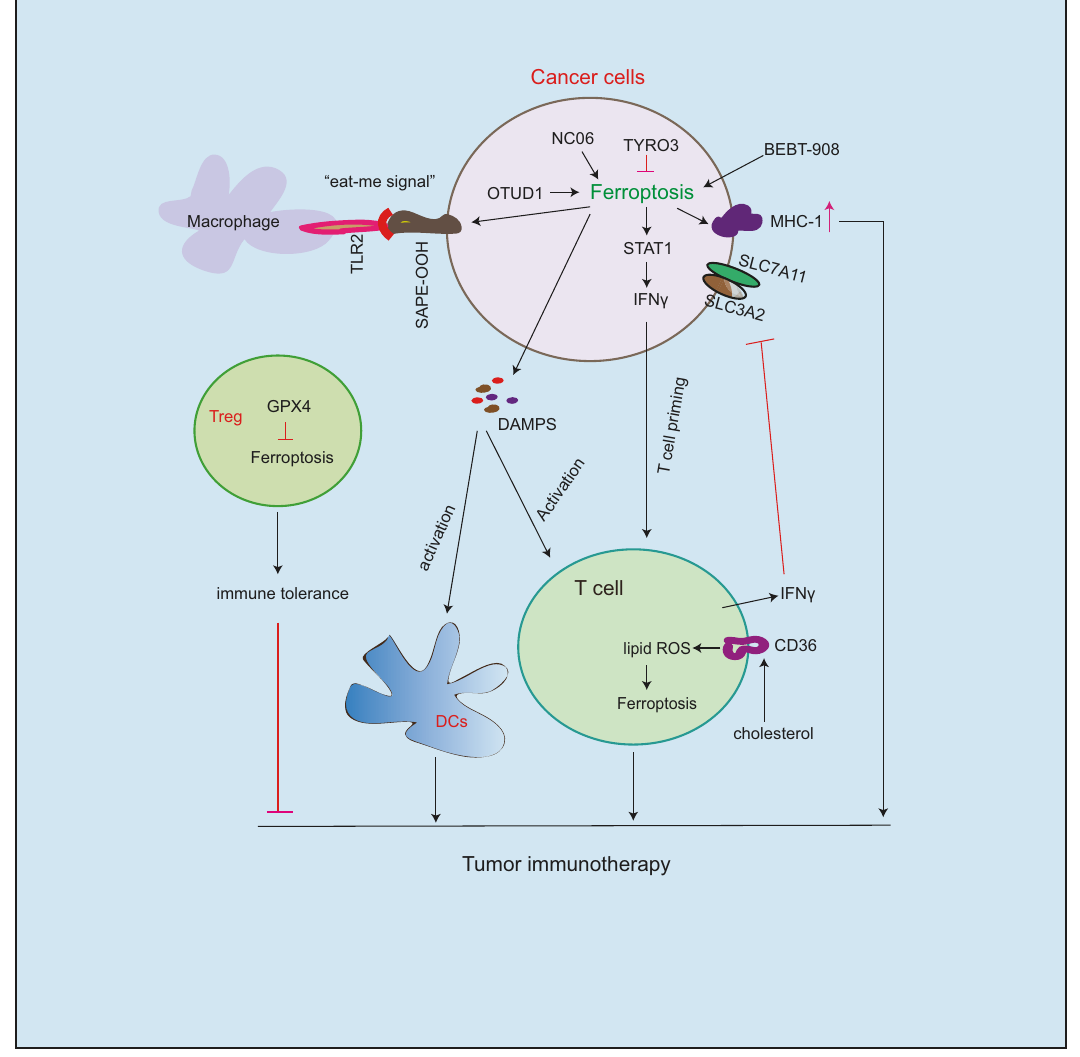
Fig. 5 Role of ferroptosis on cancer immunotherapy. Ferroptosis induction facilitates MCH-1 expression, release of DAMPS and IFN γ , which in turn activate immune cell activity including T cells and macrophages. In addition, the release of IFN γ from T cells inhibits Xc (-) system (SLC7A11/SLC3A2), leading to increased ferroptosis sensitivity. Ferroptosis resistance by GPX4 in Treg cells causes immune tolerance. As an eat-me signal, SAPE-OOH is distributed on ferroptotic cancer cells, which is recognized by TLR2 on macrophages leading to